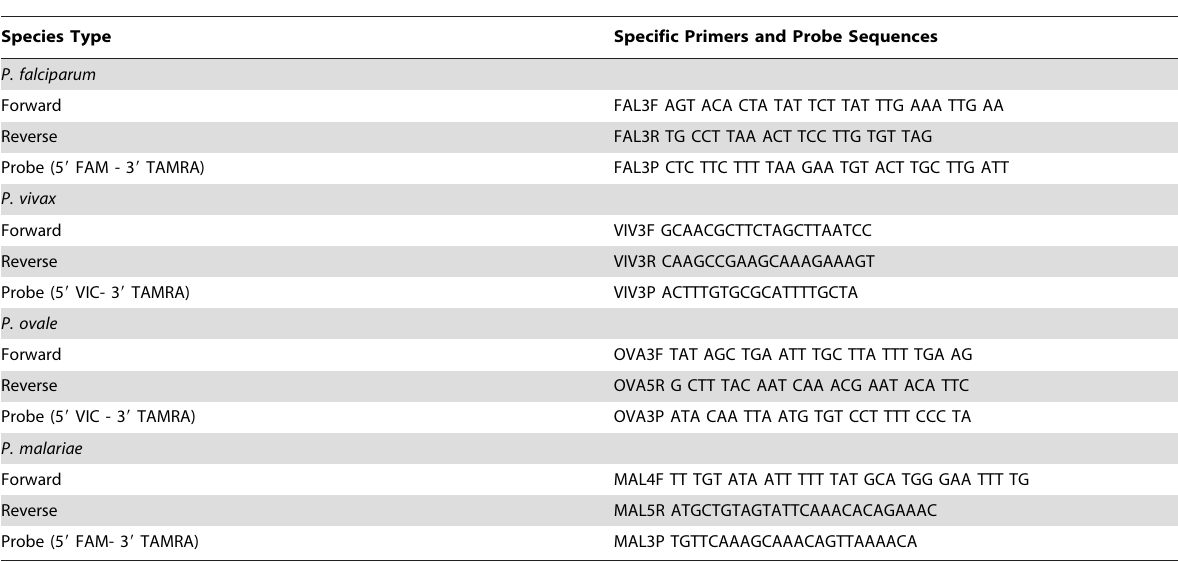
Table 1. Species-specific primers and probes for detecting Plasmodium parasites.